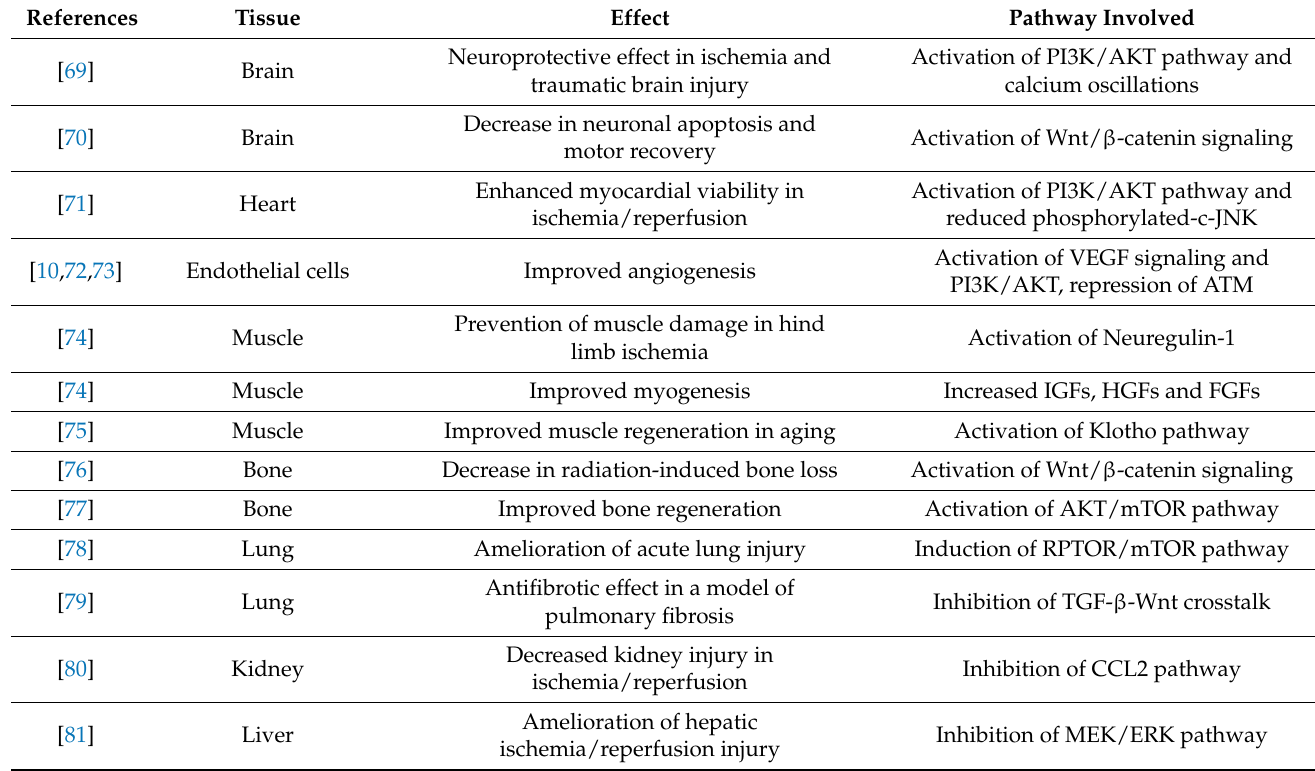
Table 1. Outline of the pathways involved in the pro-regenerative effects of EVs in different tissues. PI3K: phosphatidylinositol-3-kinase; AKT: protein kinase B; WNT: wingless-related integration site; JNK: c-Jun N-terminal kinase; ATM: ATM serine/threonine kinase; IGF: insulin-related